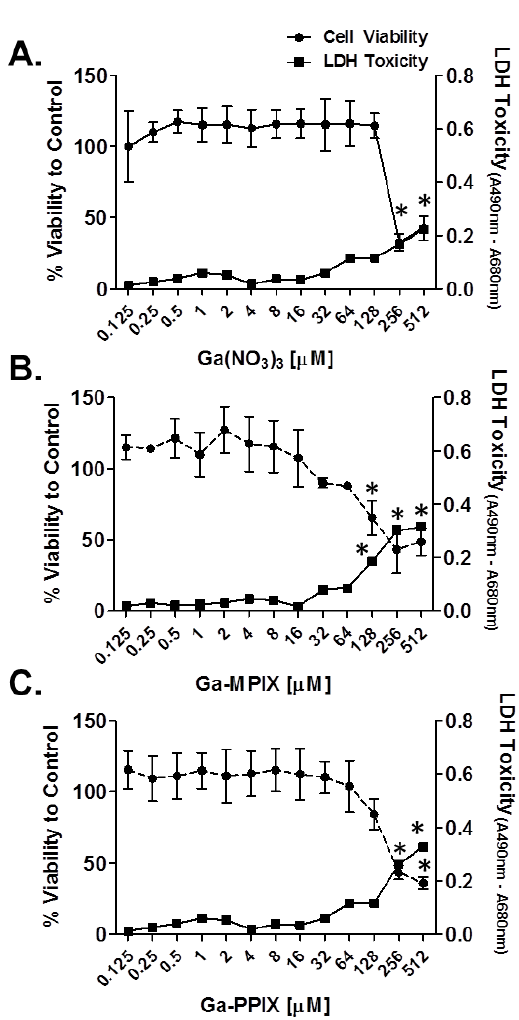
Figure 5. Evaluation of the toxicity of gallium porphyrins on primary human fibroblasts. Human fibroblasts were exposed to different concentrations (0–512 µM) of ( A ) Ga(NO 3 ) 3 ; ( B ) Ga-MPIX; or ( C ) Ga-PPIX for 24 h. Cell viability was measured using the cell titer flour assay and viability was expressed as a percentage compared to untreated control groups. Cytotoxicity was evaluated by measuring the amount of lactate dehydrogenase (LDH) in culture supernatants of cells ( A 490nm ) treated with the gallium compounds. Values are expressed as the mean ± SD of three independent experiments. * p < 0.01 relative to the untreated control group.